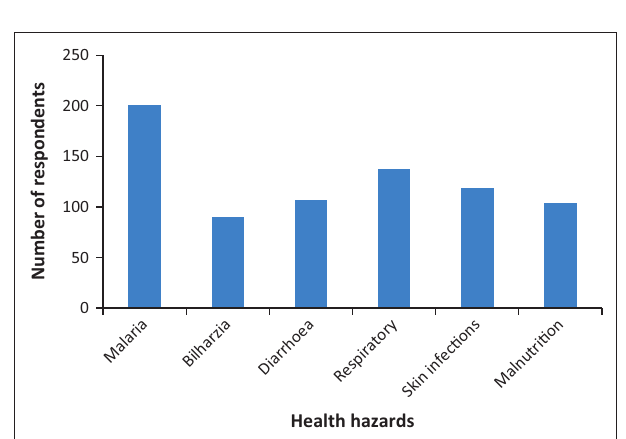
FIG URE 2: Respondents’ perceptions of the health hazards experienced because of changes in climate status ( n =